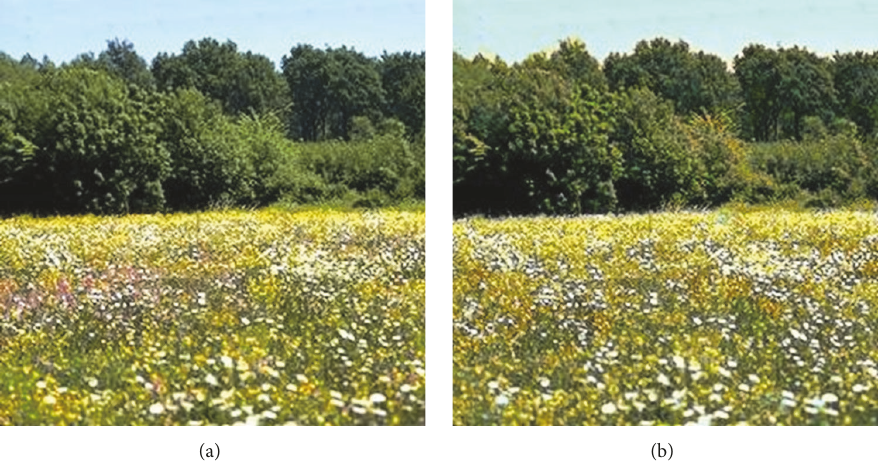
Figure 3: Original image (a) and the recovered color image (b) using learned three-dimensional feature vector after